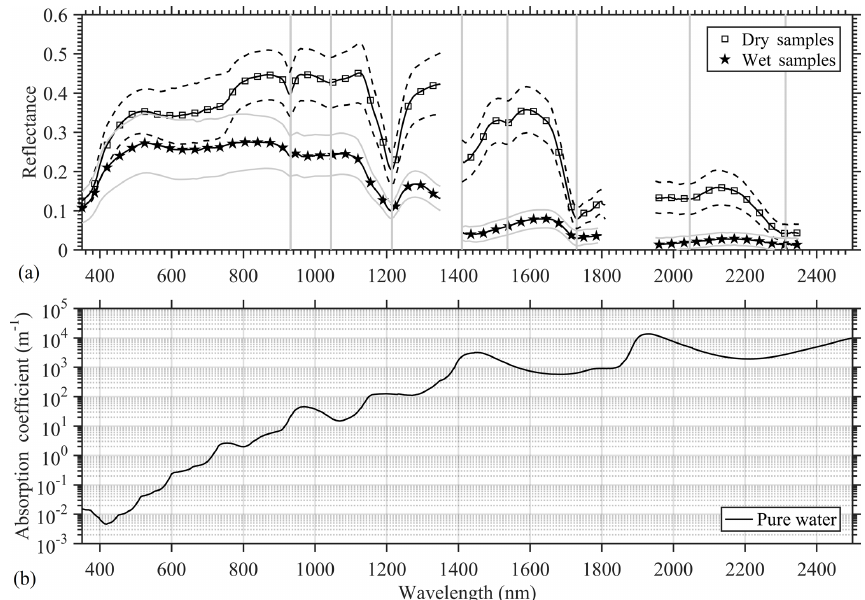
Figure 5. (a) Mean bulk spectral reflectance of dry and wet marine-harvested microplastics ± standard deviation (dashed lines). Absorption features noted in marine-harvested microplastics are highlighted by the vertical lines (centred around ∼ 931, 1045, 1215, 1417, 1537, 1732,